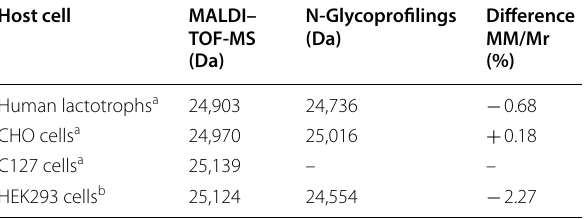
Human lactotrophs a